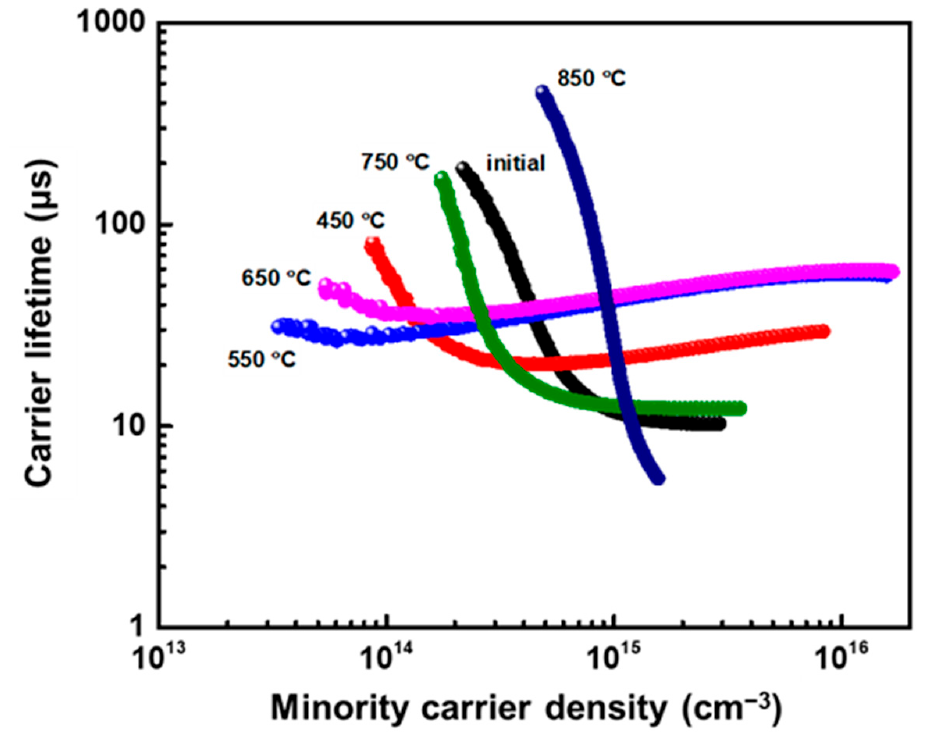
Figure 2. Carrier lifetime of the Al 2 O 3 / SiN x :H / mc-Si wafer samples determined by QSSPC measurement at different annealing temperatures.